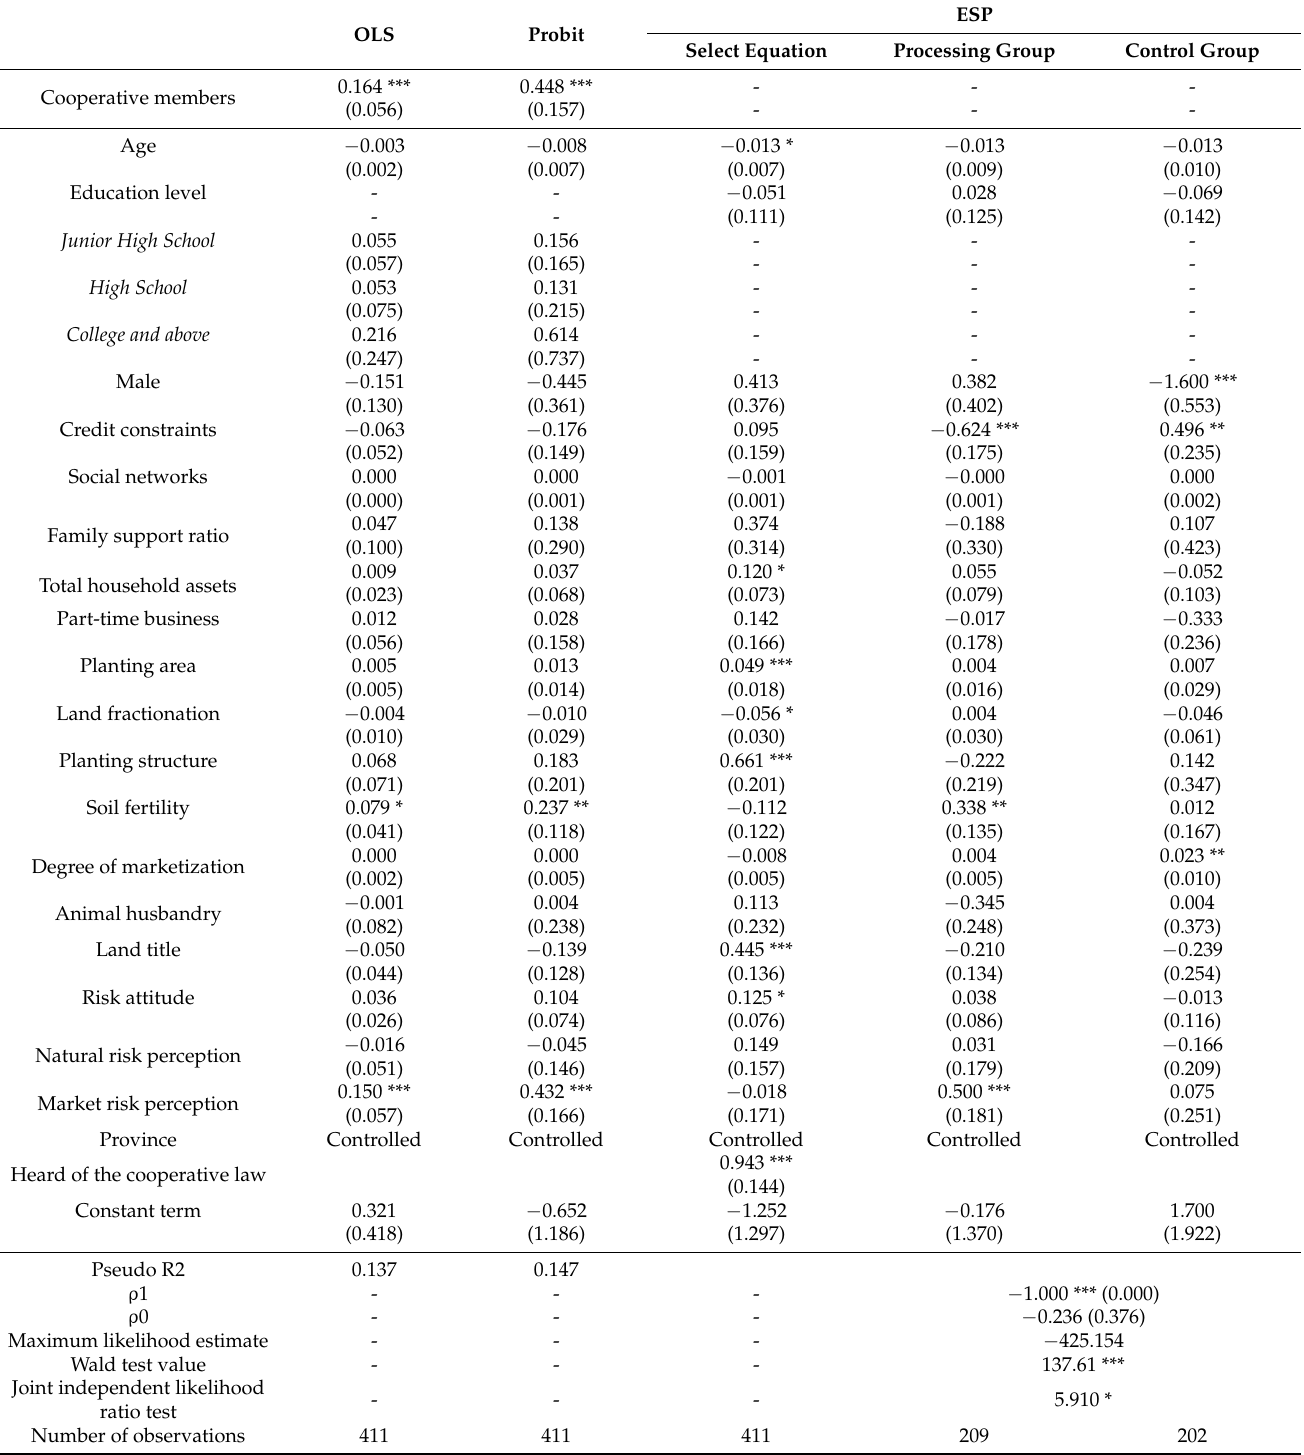
Table 3. OLS, Probit, and ESP estimates of farmers’ adoption of commercial organic fertilizer technology vis- à -vis their cooperative membership.